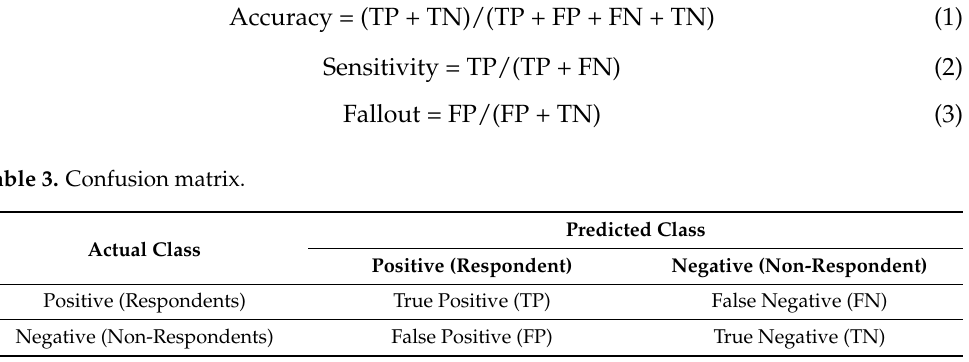
Table 3. Confusion matrix.